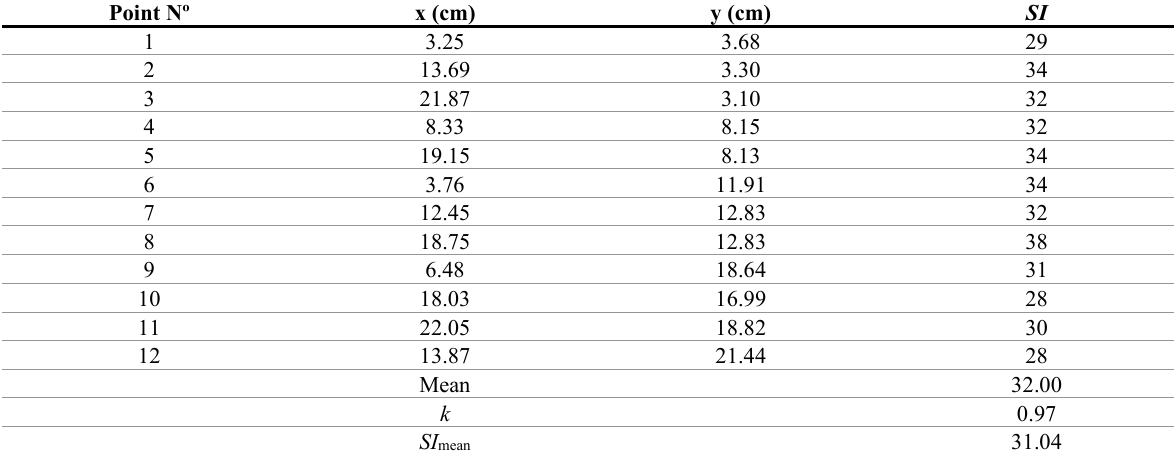
Table 2. Results of the Sclerometric index established in NBR 7584